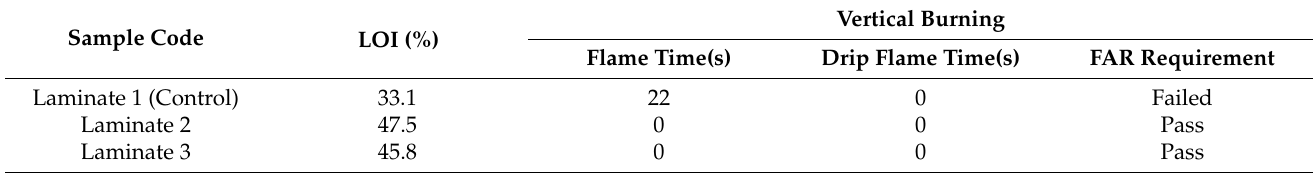
Table 3. The values of the limited oxygen index (LOI) and vertical flame test.